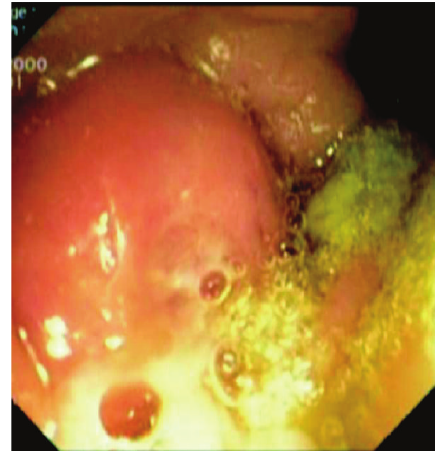
Figure 2: Purulent discharging from the appendiceal orifice.